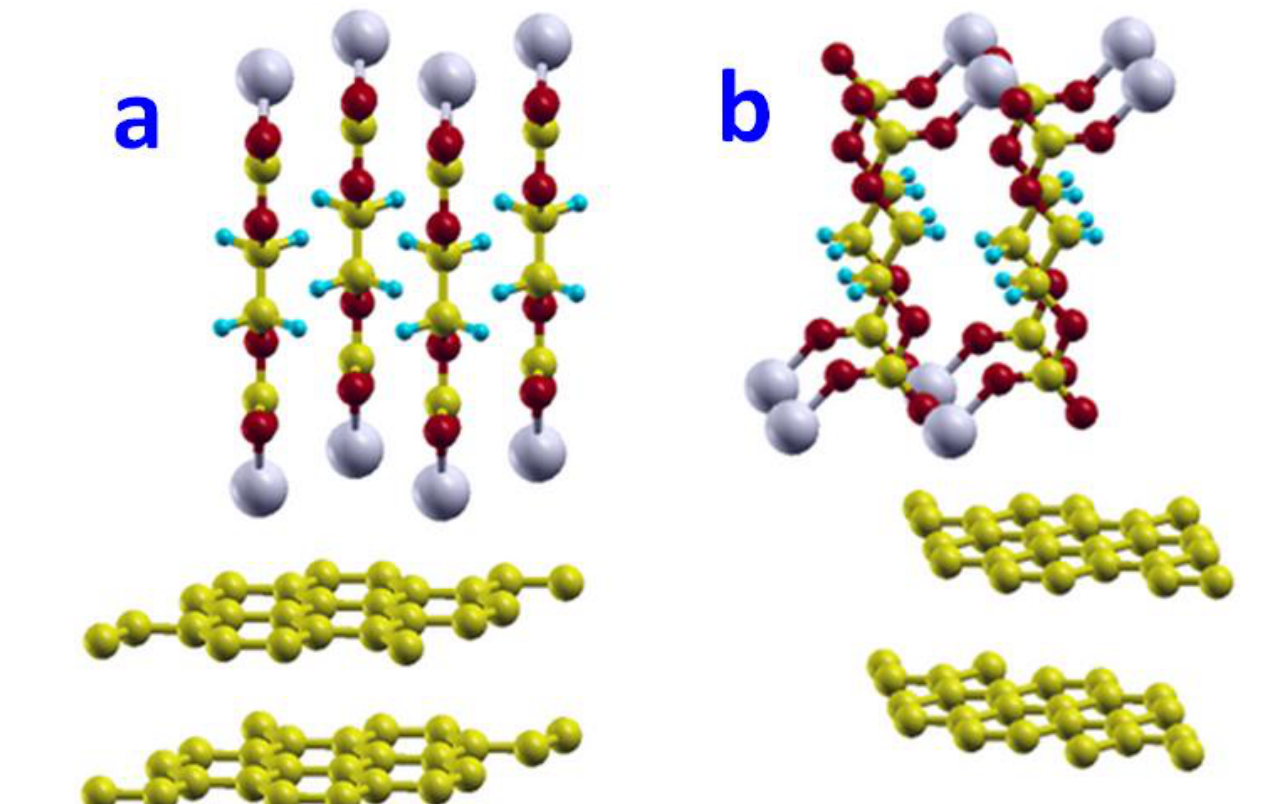
Figure 5. The network of (CH 2 OCO 2 Li) 2 molecules on basal surface of graphite: ( a ) initial structure ( b ) final structure.